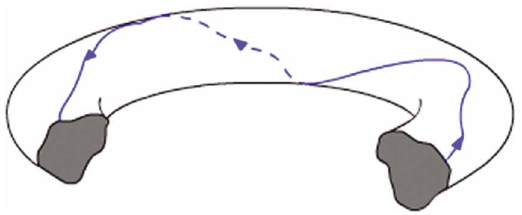
Fig. 15. Disturbed two-dimensional energy